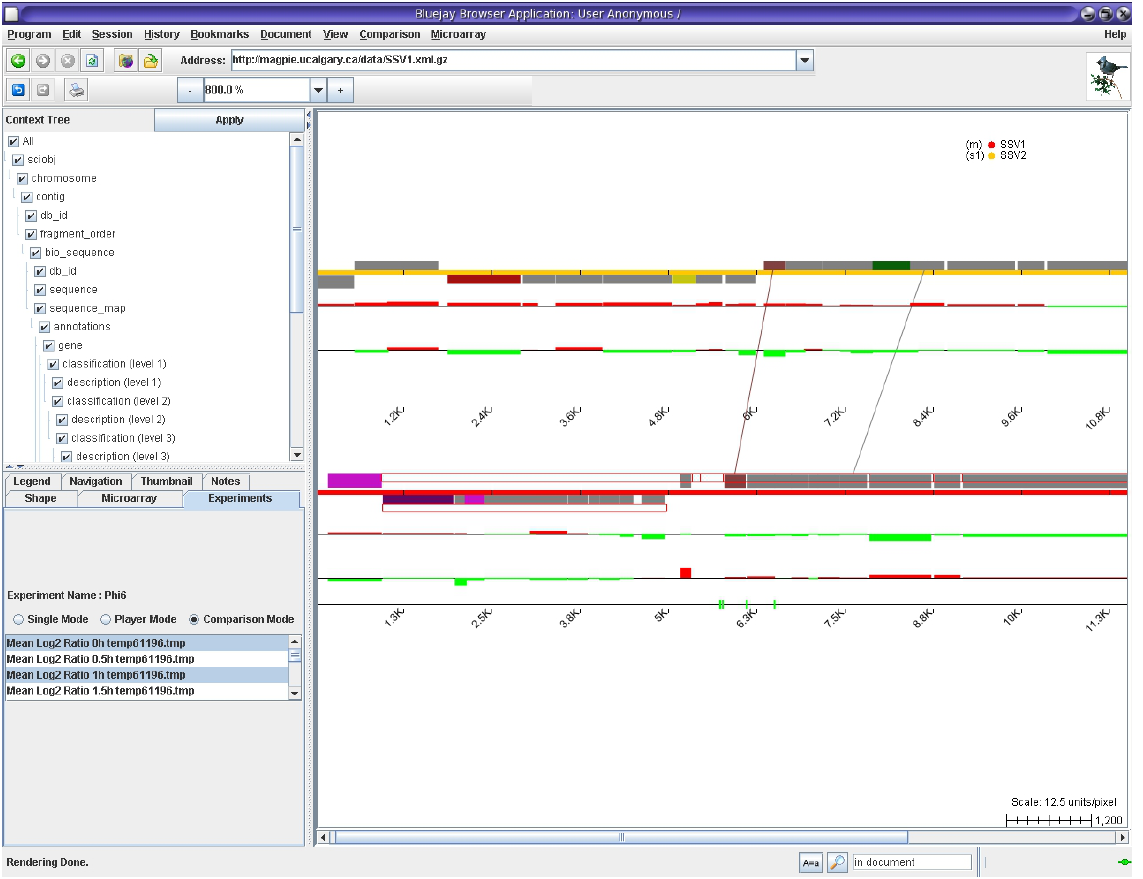
Figure 5: Linear shape view of the same genomes and microarray datasets as in Figure